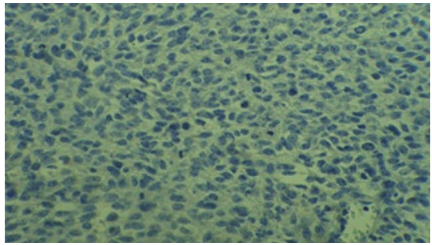
Figure 4: CD57 positivity with mitotic figure in tumoral